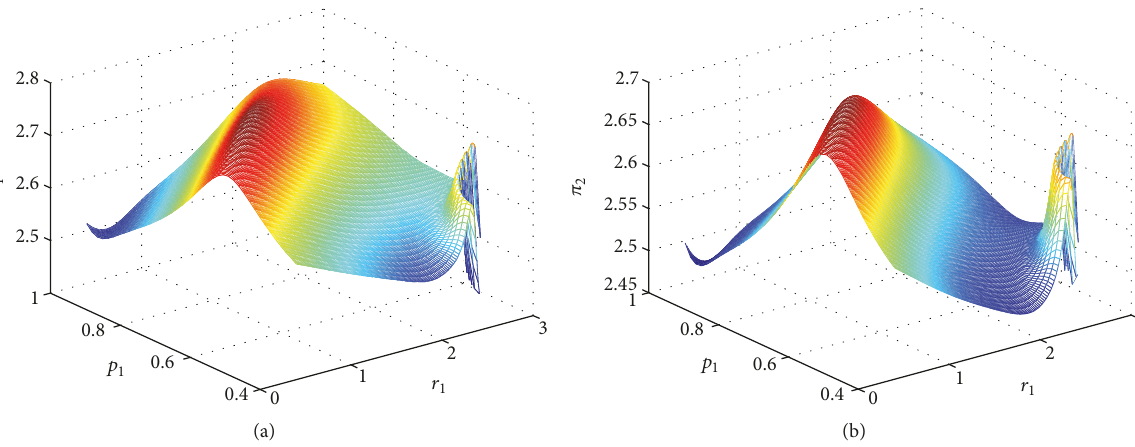
Figure 17: The average profits with respect to initial 𝑟 1 and 𝑝 1 when 𝜃 = 0.5 , 𝛼 = 0.5 , 𝑤 1 = 𝑤 2 = 0.5 , and 𝛼 1 = 𝛼 2 = 0.25